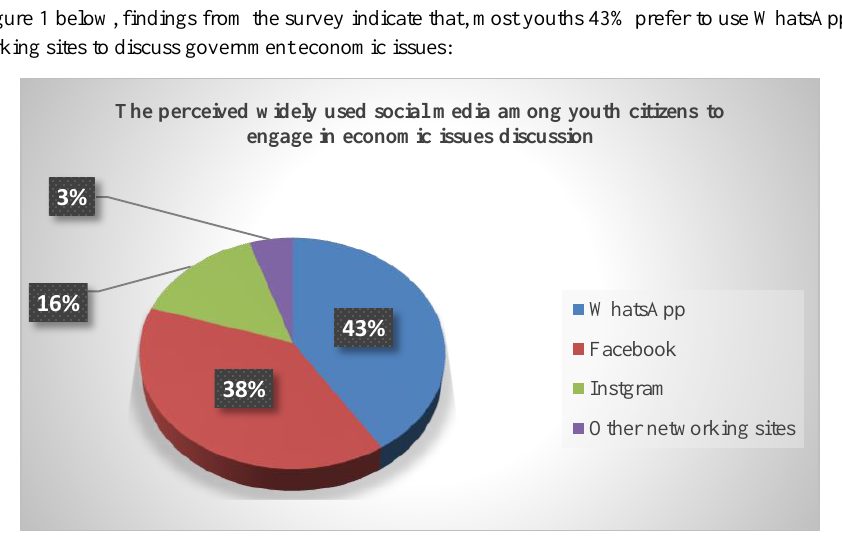
Figure 1 : Showing the Perceived Widely Used Social Media Among Youth